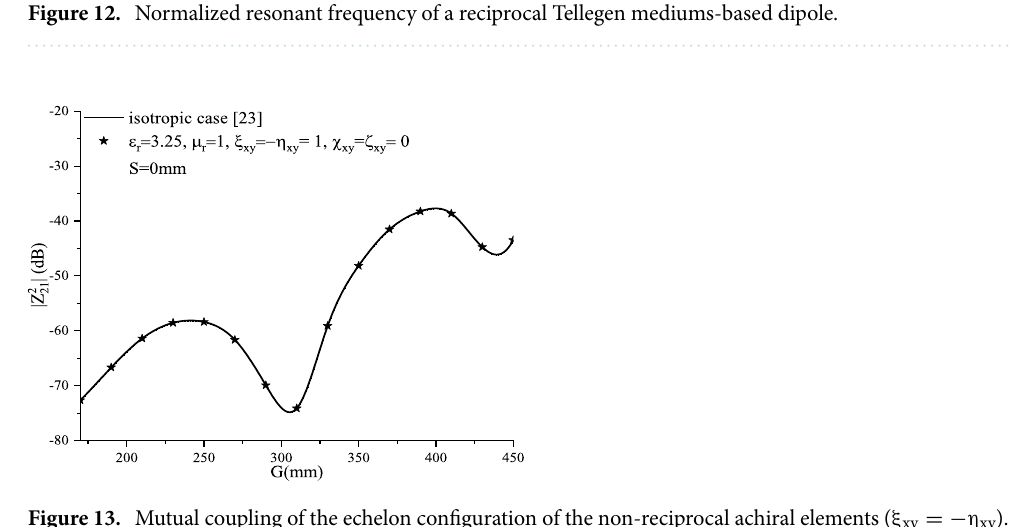
Figure 13. Mutual coupling of the echelon configuration of the non-reciprocal achiral elements ( ξ xy